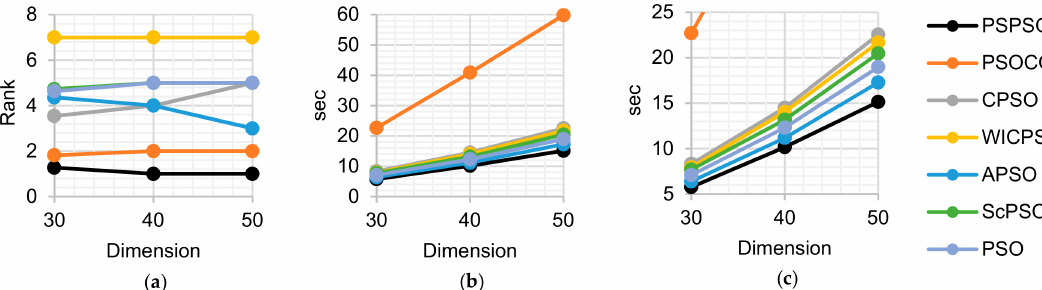
Figure 4. PSO variants in increasing dimension for ( a ) average rank in function evaluation, and ( b ) average computational time. ( c ) Enlargement of ( b ).